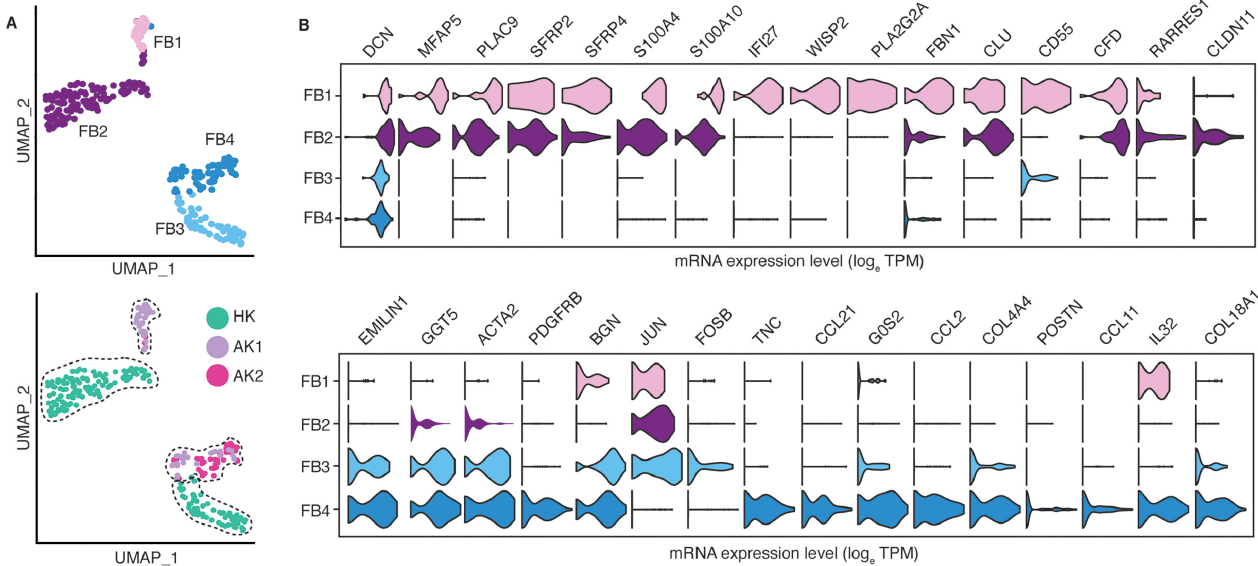
Fig 3. Sub-clustering of fibroblasts revealed four distinct subtypes. (A). UMAP-based visualization of subpopulations of fibroblasts. In the top panel the fibroblasts are colored by different sub-populations. In the bottom panel the cells are colored by the biopsies HK, AK1 and AK2. (B). Violin plots depict the expression of the lineage gene